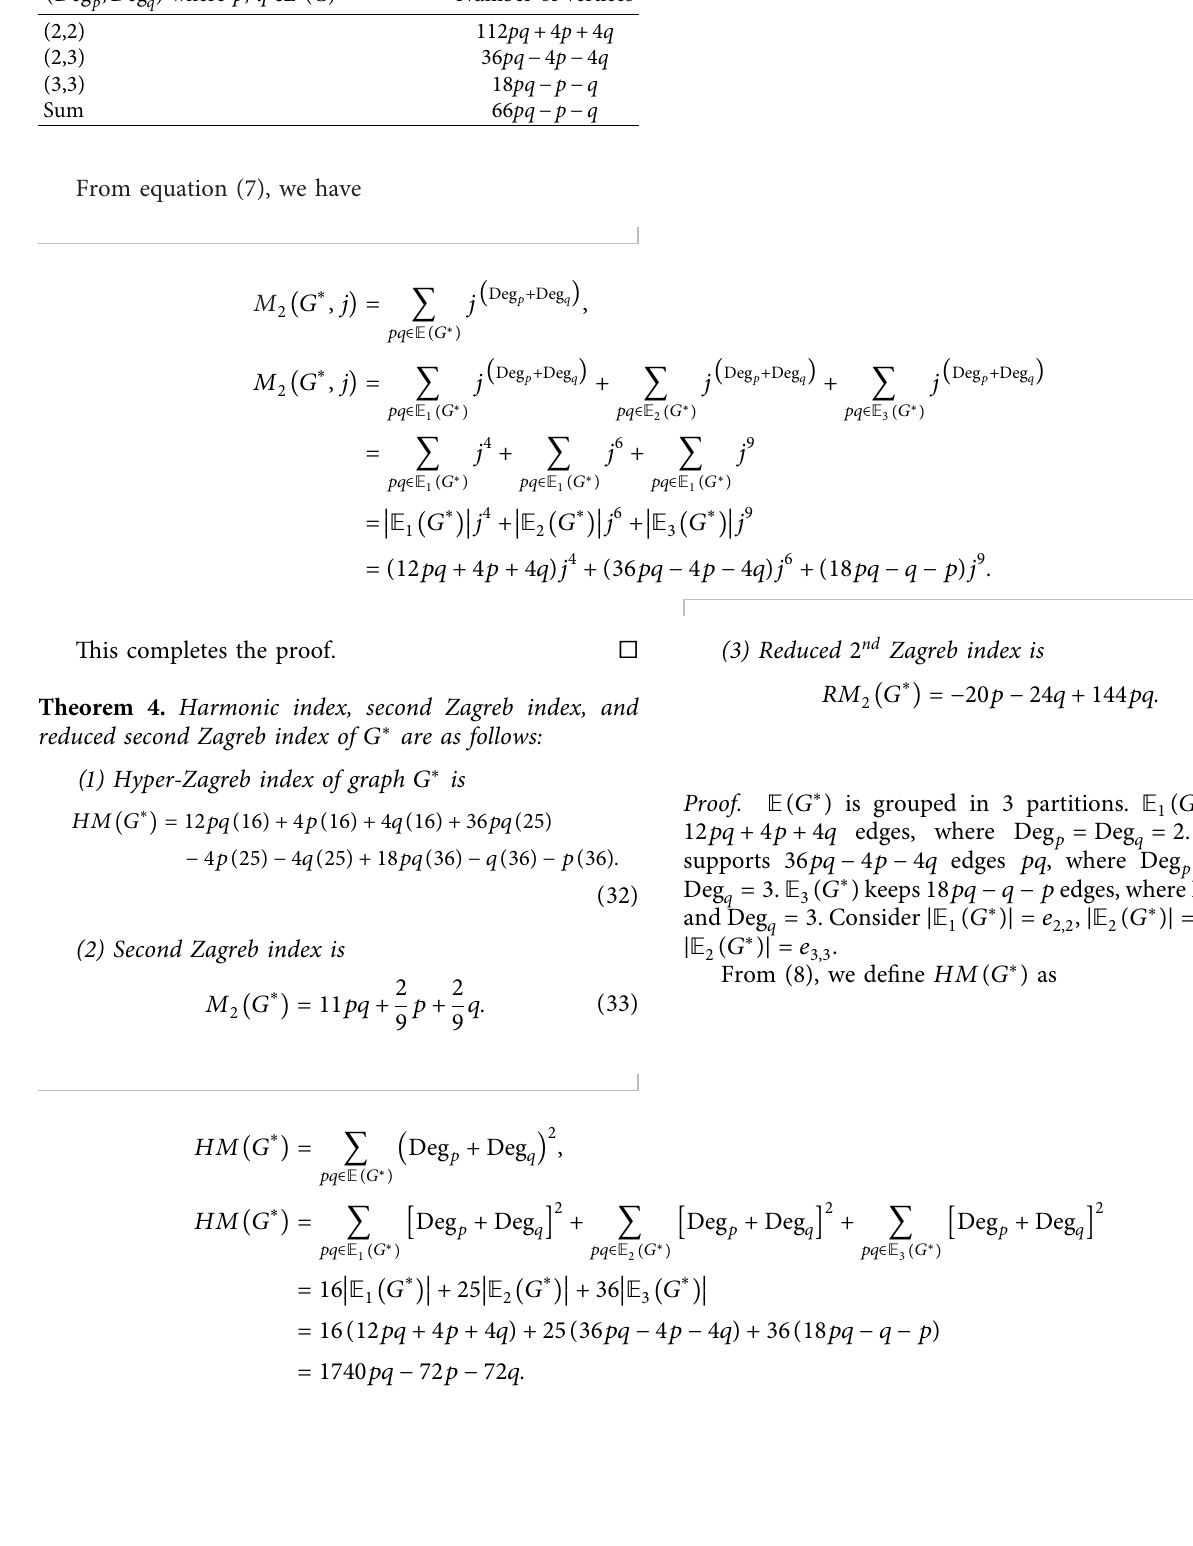
Table 3: Edge partition of graph G ∗ with respect to starting and ending vertices of each edge. ( Deg , Deg ) where p , q ε E ( G p q